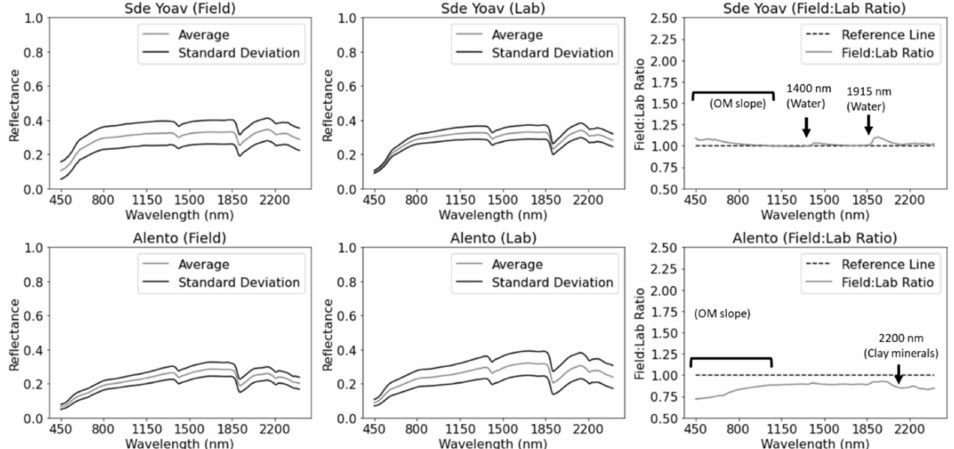
Figure 6. Average reflectance obtained in the field and laboratory and average spectral ratio between field and laboratory spectral measurements (per field) for the clayey